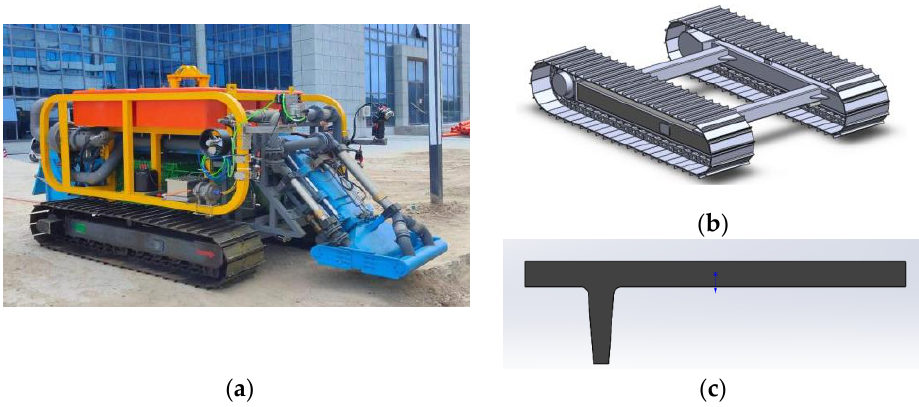
Figure 3. Structural details of “Pioneer-I” DSMV. ( a ) DSMV model, ( b ) Track mechanism, ( c ) Track plate model.